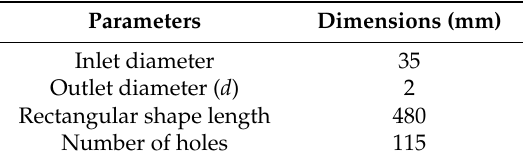
Figure 2. Diagram of a basic gas torch. Table 1. Specifications of a basic gas torch.